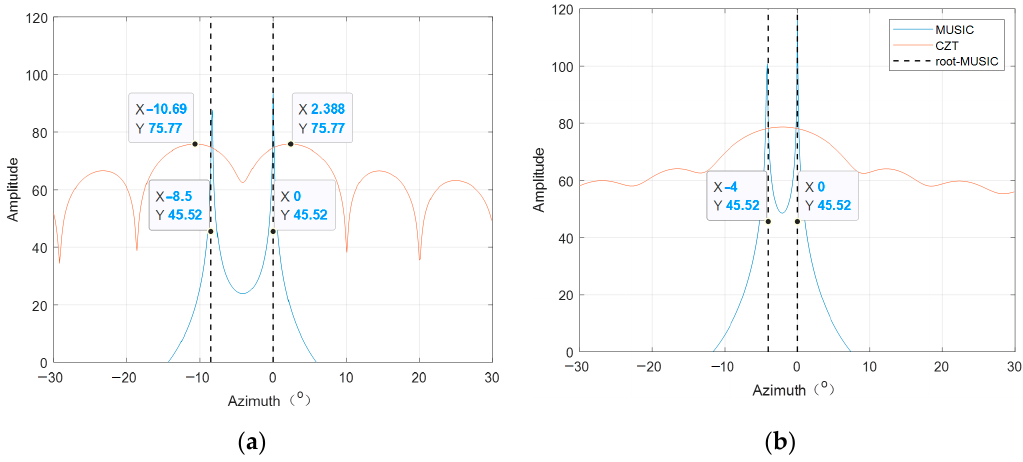
Figure 5. Multiple targets resolving ability. ( a ) DOA curves of two targets separated by one angular resolution; ( b ) DOA curves of two targets separated by half the angular resolution.